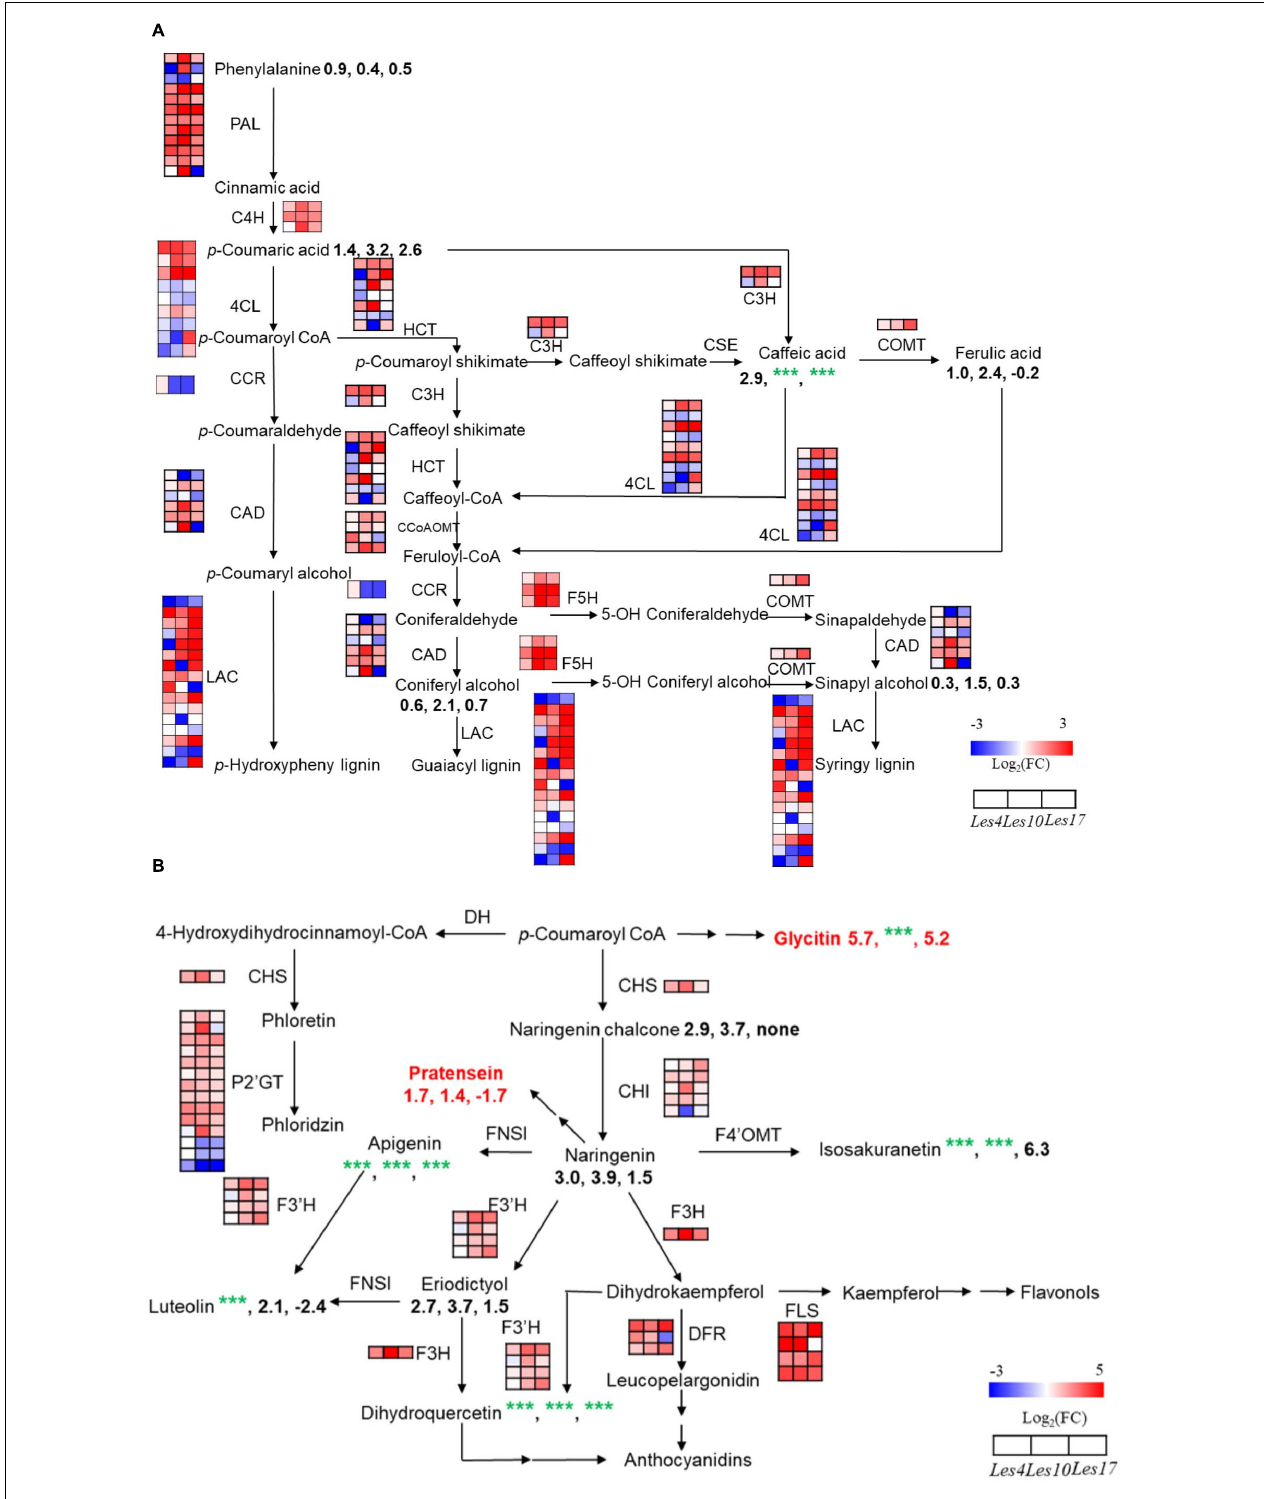
FIGURE 5 | Integrated transcriptomics and metabolomics analysis of lignin and flavonoid biosynthesis. (A) Genes and metabolites involved in lignin biosynthetic pathway in the comparisons of Le4 , Les10 , and Les17 mutants and their respective wild type (WT). (B) Genes and metabolites involved in flavonoid biosynthetic pathway in the comparisons of Le4 , Les10 , and Les17 mutants and their respective WT. For (A,B) , the different rows of each heatmap represent the different